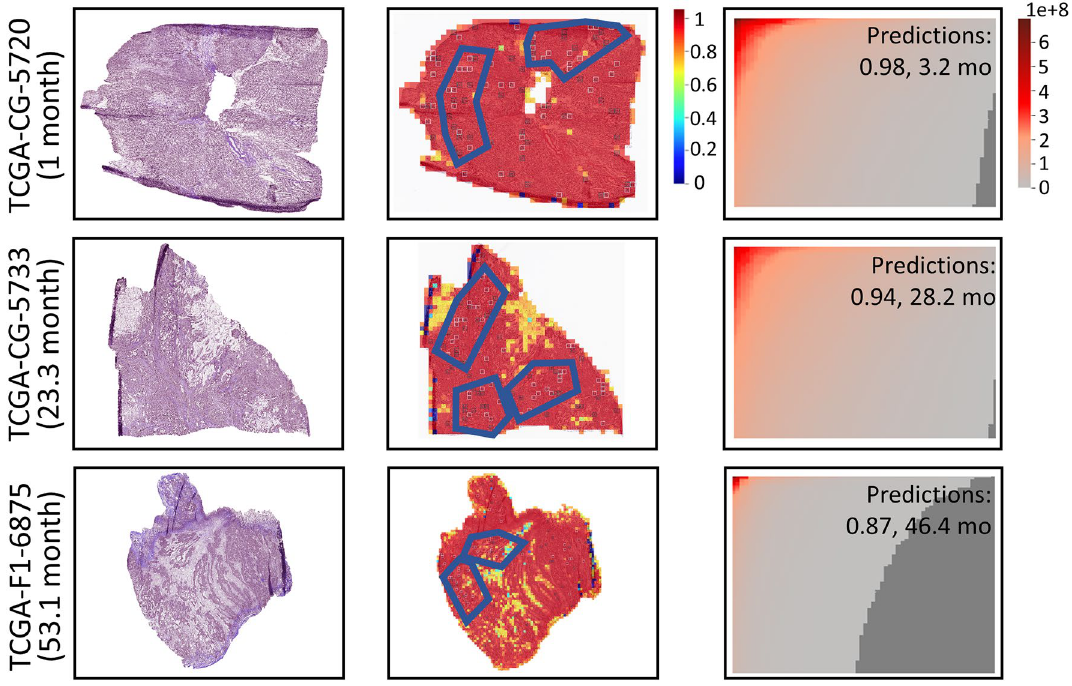
Figure 13. The original WSIs (left), patch-wise probability maps (middle), and HipoMaps (right) of the three patients, who survived one month (TCGA-CG-5720), 23.3 months (TCGA-CG-5733), and 53.1 months (TCGA-F1-6875) in TCGA-STAD.